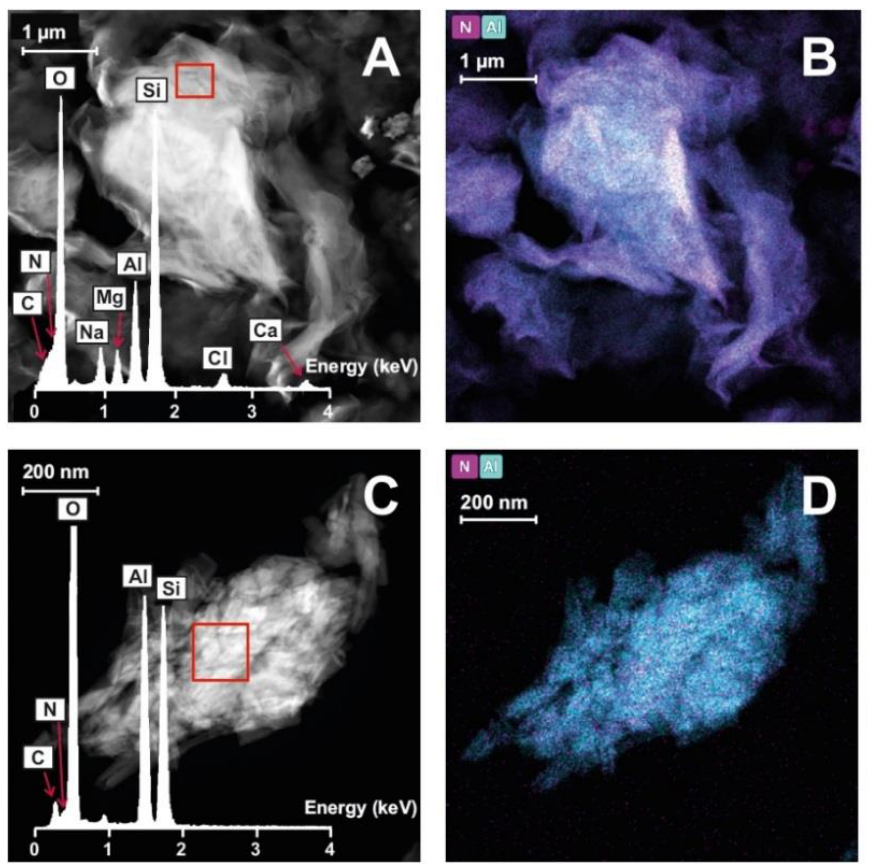
Figure 7. UHR-TEM microphotographs with EDX spectra and elemental maps of CHX – BEN ( A and B , respectively) and CHX – HAL ( C and D , respectively).